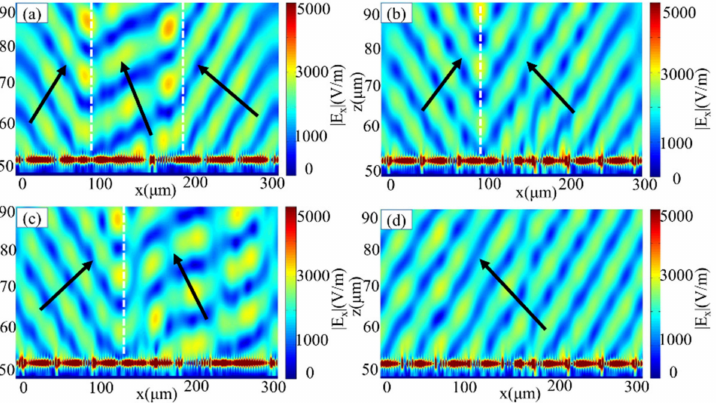
Figure 3. The graphene metasurface was designed to operate at 12.32 THz. ( a ) Reflected electric field Ex-distribution in the three anomalous deflection directions of the metasurface with a Fermi energy level of 0.64 eV. ( b ) Symmetric and ( c ) asymmetric anomalous reflection electric field Ex distribution of two beams, ( d ) anomalous reflection electric field Ex distribution of single beam at fixed structure parameters as various the Fermi energy level of the graphene